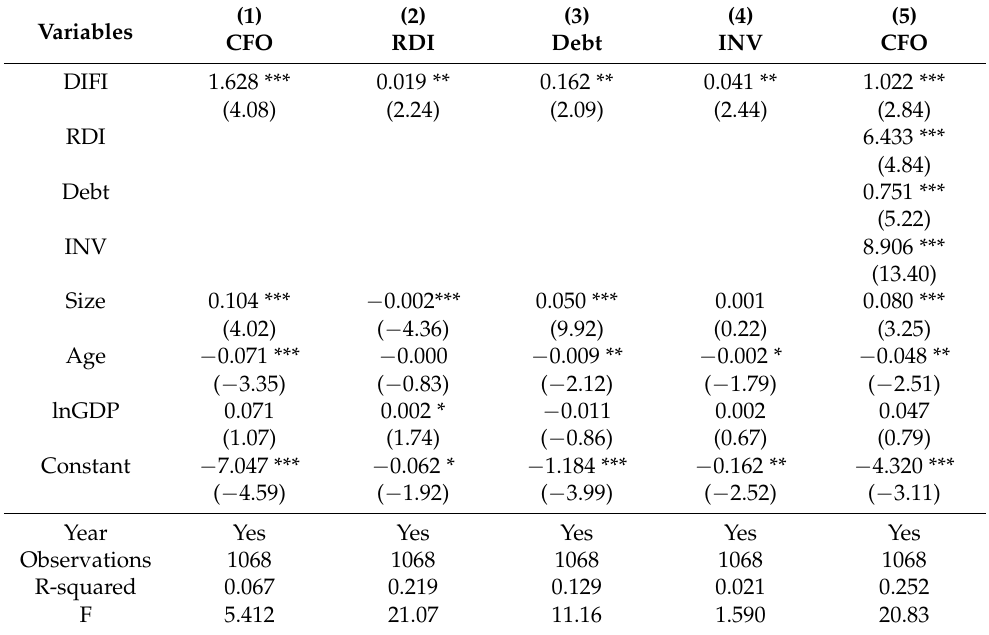
Table A1. Robustness test of mediating effect with substitute dependent